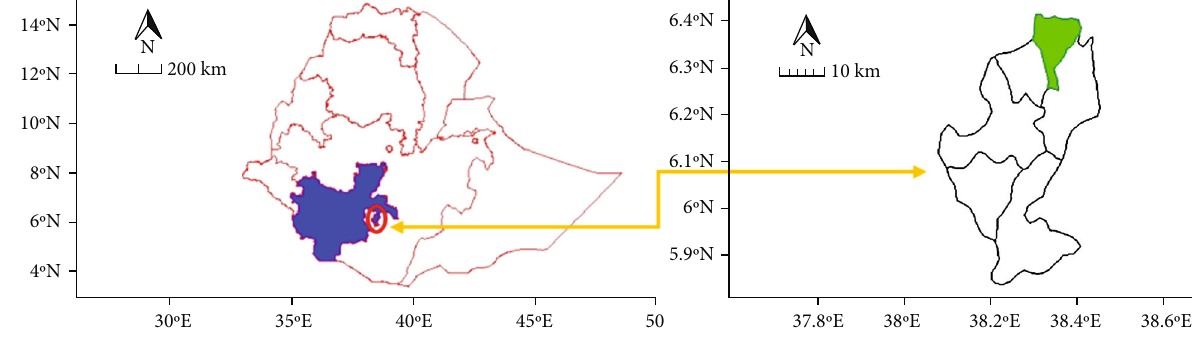
Figure 1: Research site location (blue color: SNNPRS; green color: Dilla Zuria woreda in Gedeo